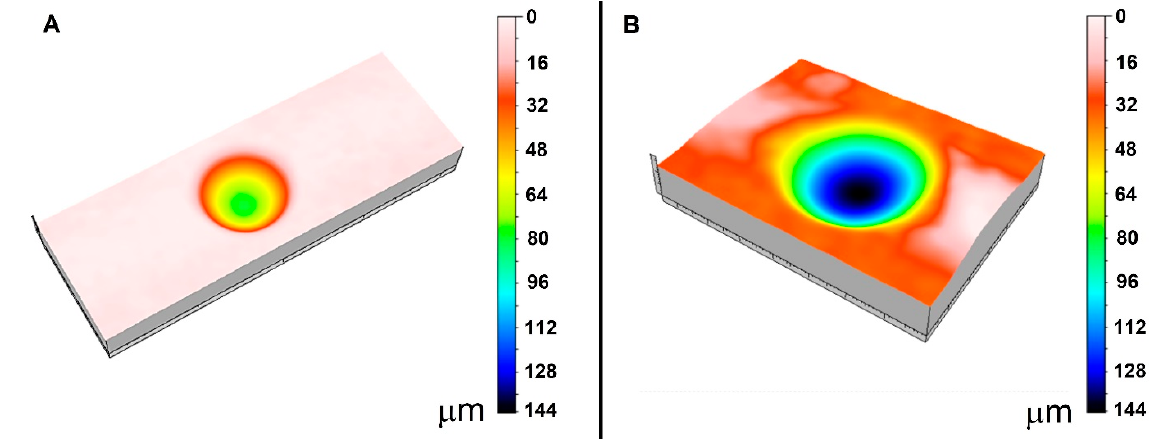
Figure 9. Three-dimensional wear scar topographies corresponding to ( A ) α - β 20T and ( B ) TC3030 ceramics after the 900 s tribotest.